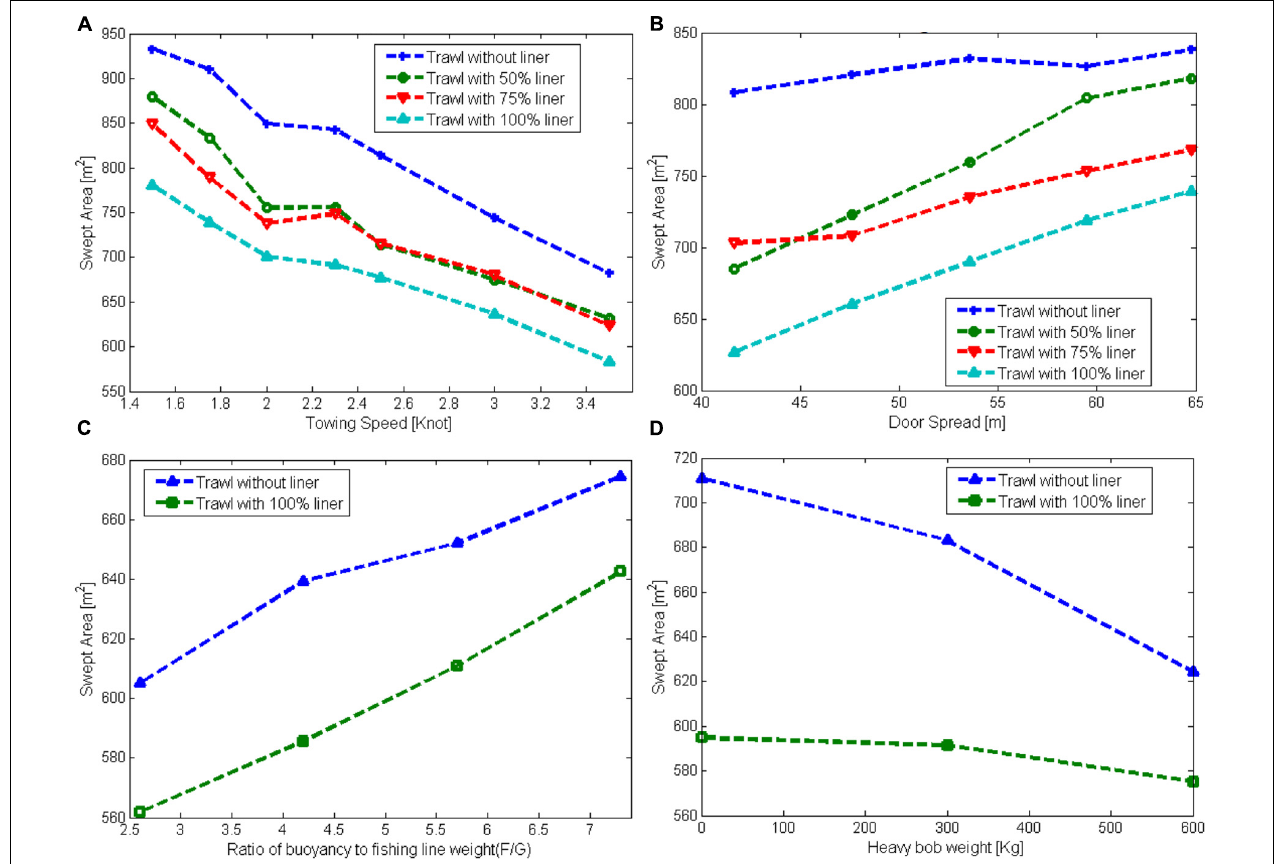
FIGURE 11 | The swept area of different trawls about the (A) towing speed, (B) door spread, (C) ratio of buoyancy to F / G , and (D) heavy bob weight: current data estimated with 95% confidence intervals from the statistical